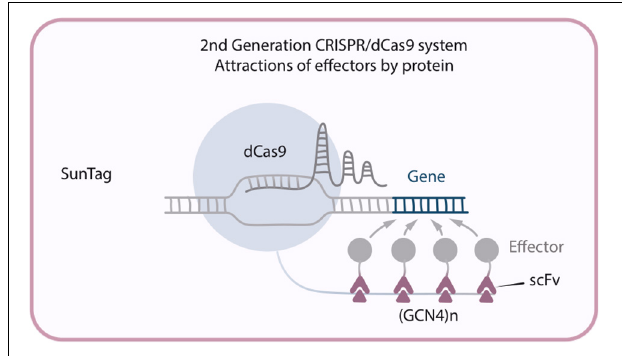
FIGURE 3 | Second generation CRISPR/dCas9 system SunTag, in which multiple copies of GCN4 recruit multiple molecules of the chimeric scFv antibody-activator protein to the target site.